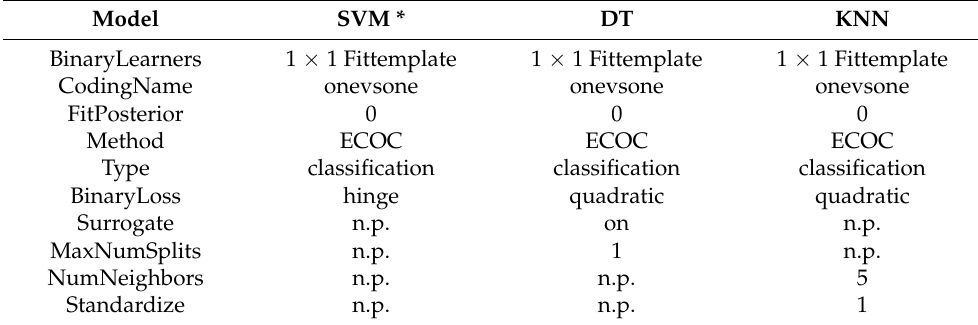
Table 4. Parameter setup for training the SVM, DT, and KNN models.